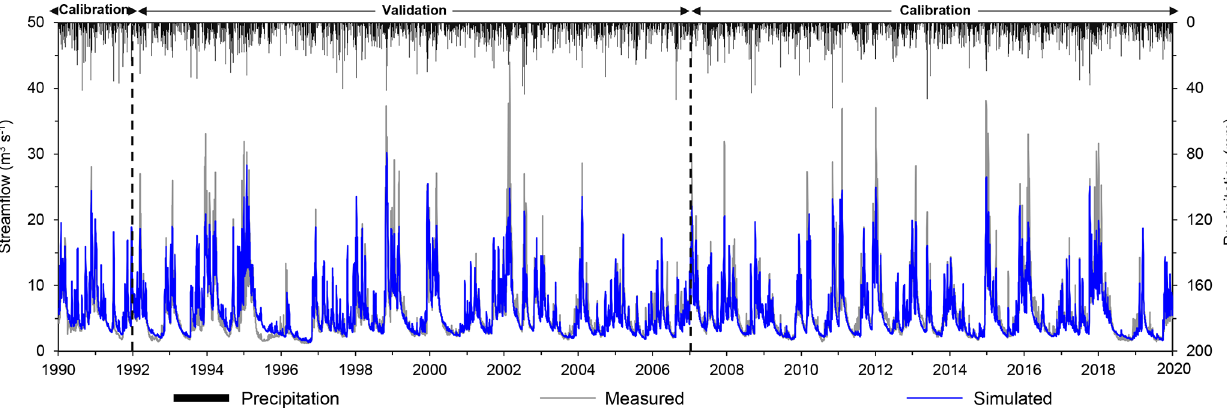
Figure 2. Comparison of measured and modeled daily streamflow during the calibration and validation periods in Willenscharen. Table 3. Performance metrics for the model calibration and validation